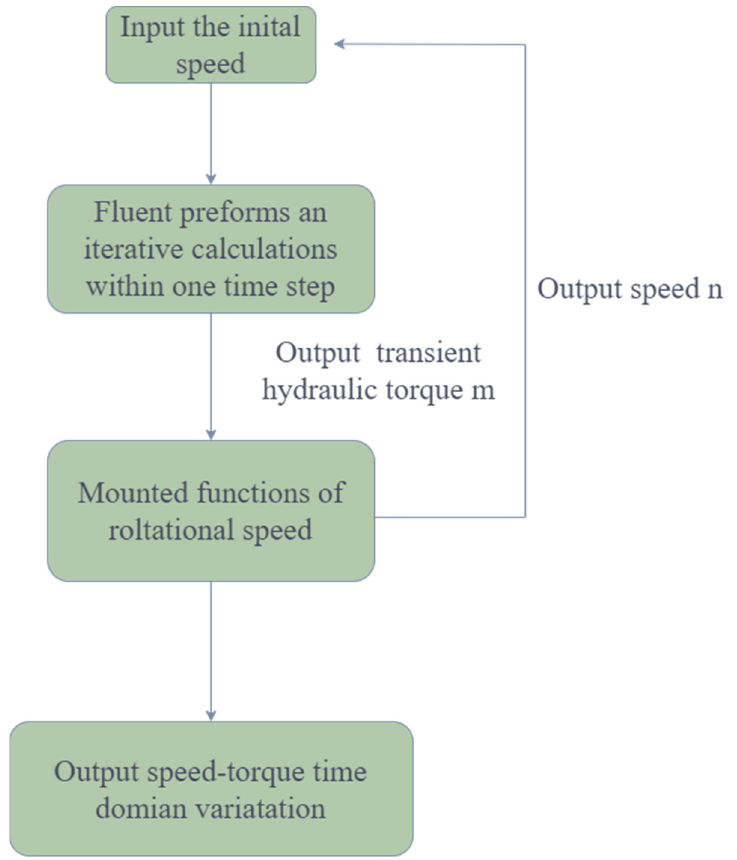
Figure 3. Flowchart of Fluent UDF macro-operation.